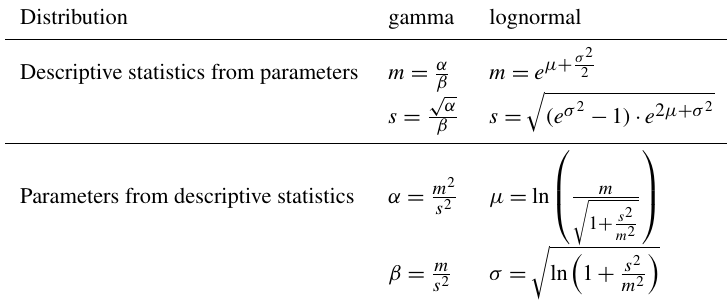
Table 1. Equations for converting between descriptive statistics and parameters of the gamma and lognormal distributions. Distribution gamma lognormal Descriptive statistics from parameters m = α β